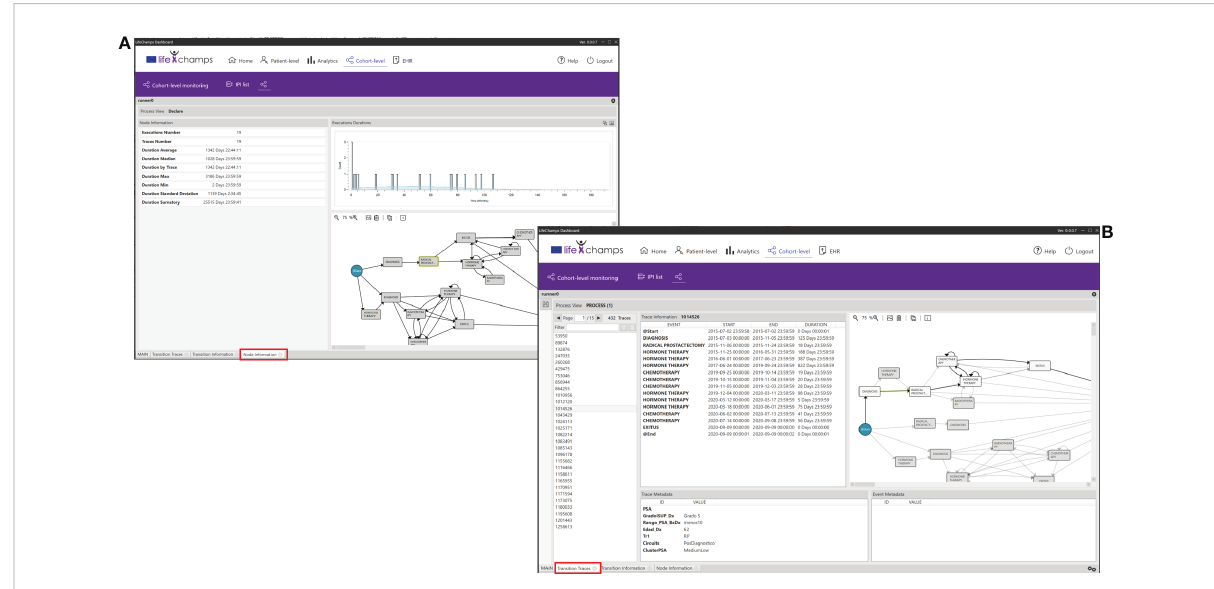
FIGURE 10 Perspectives. IPI perspective including the (A) Node and Transition Information, and the (B) Node and Transition